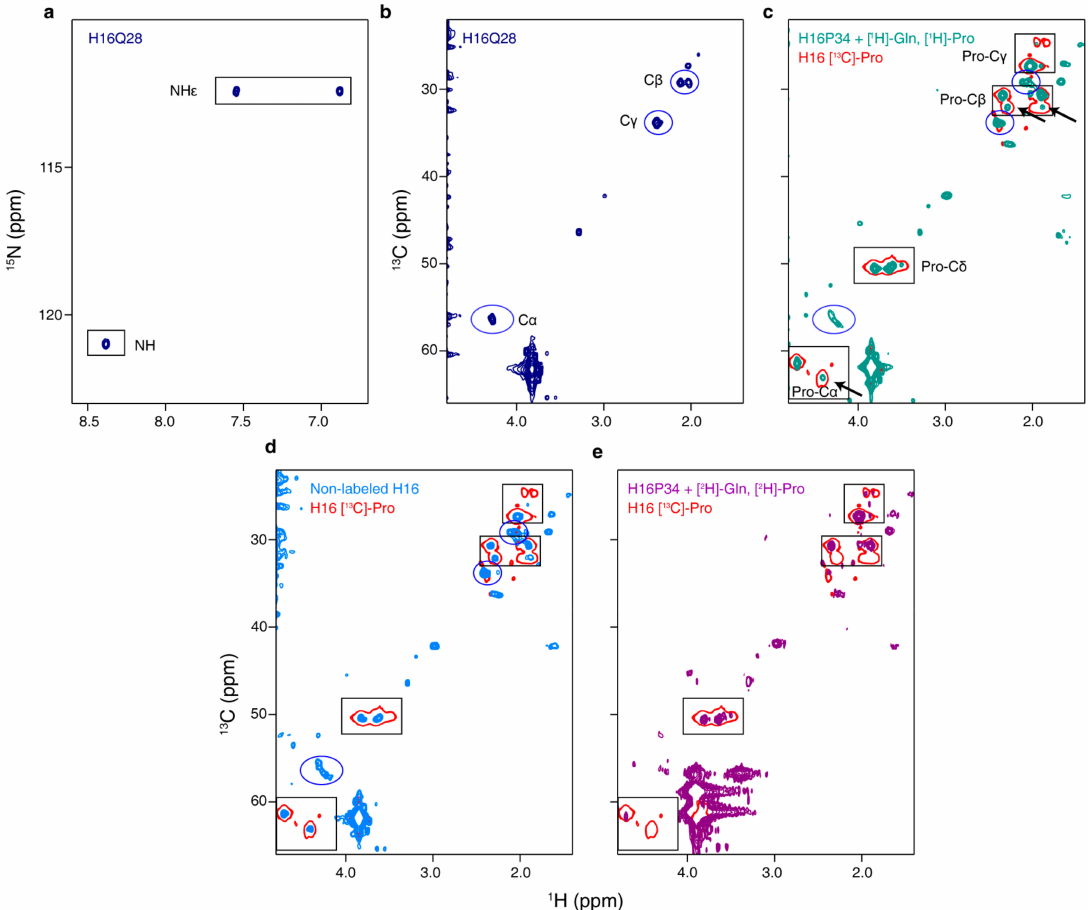
Figure 8. Site-specific isotopic labeling of H16. ( a , b ) 15 N and 13 C-HSQC spectra of site-specifically [ 15 N, 13 C]-labeled Q28 of H16. ( c ) 13 C-HSQC of H16 P34 (dark green) expressed in a CF reaction using non-deuterated Pro and Gln. The spectrum of a H16 sample with all Pro 13 C-labeled (H16 [ 13 C]-Pro) is shown in red. Blue circles and black arrows indicate the presence of natural abundance CH signals arising from Gln and Pro, respectively. ( d ) Overlay of the 13 C-HSQC spectra of H16 [ 13 C]-Pro (red) and a non-labeled H16 (blue) sample. ( e ) Overlay of the 13 C-HSQC spectra of H16 [ 13 C]-Pro (red) and H16P34 expressed in a CF reaction in the presence of deuterated Pro and Gln